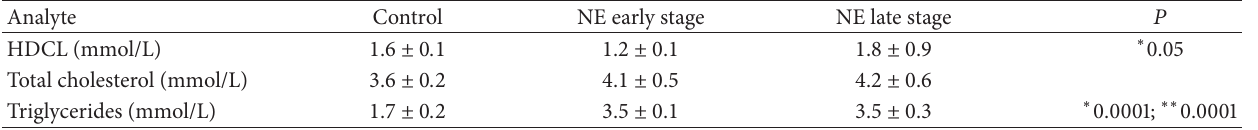
Figure 1: Subio analysis of triglycerides and HDCL in male and female NE cases. Differential abundance of the metabolites concentration was calculated using the Subio Platform (Subio Inc., Kagoshima, Japan) with a differentiation expression threshold of 1.5-fold ( 𝑡 -test, 𝑃 < 0.05 ). Table 2: Lipid profile in NE patients.